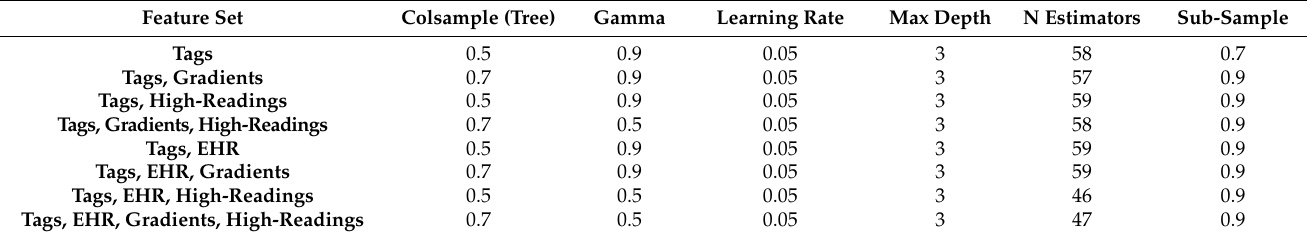
Table A3. Hyperparameter values used in model development (XGBoost).